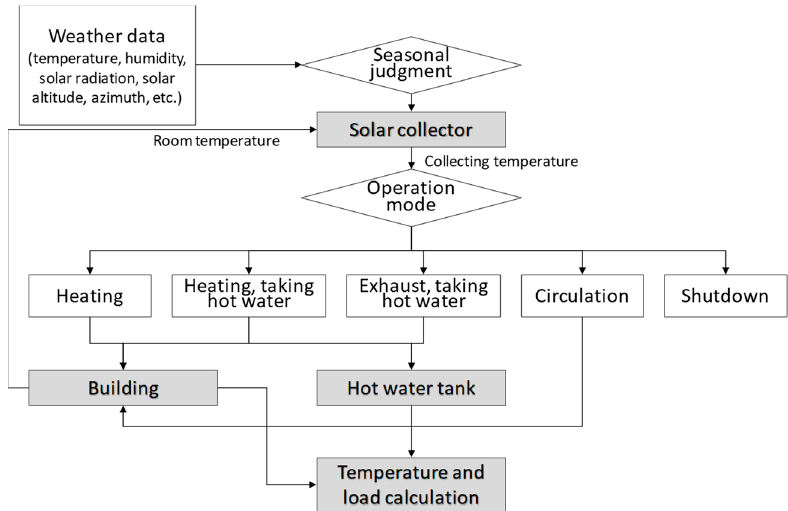
Figure 1. Simulation flow chart.